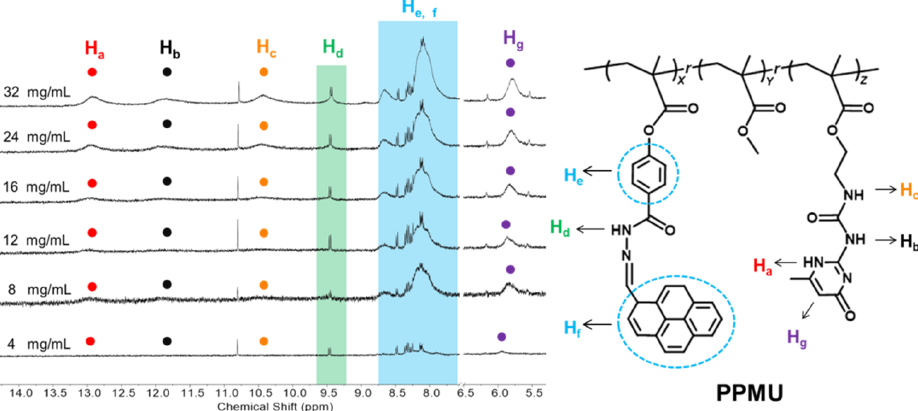
Figure 1. Partial 1 H NMR spectra (400 MHz, CDCl 3 , 298 K) of PPMU at different concentrations (4 mg/mL, 8 mg/mL, 12 mg/mL, 16 mg/mL, 24 mg/mL, 32 mg/mL).